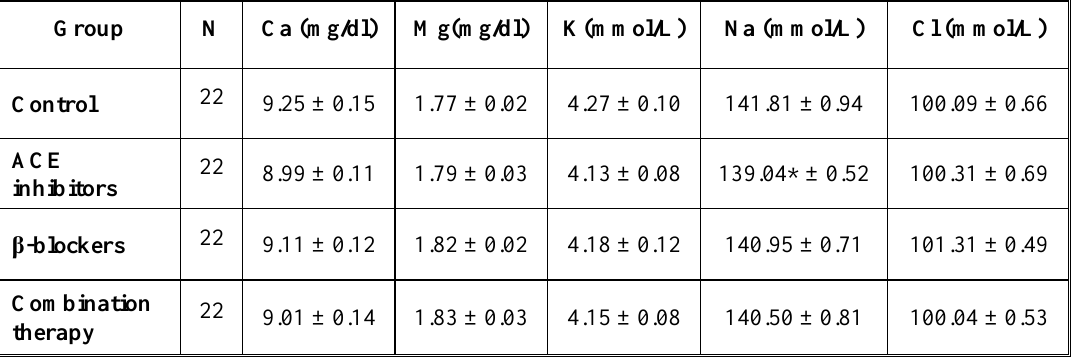
Table 8: Serum electrolytes (Ca +2 , Mg +2 , K +, Na + , Cl - ) in control healthy individuals and hypertensive patients treated with different antihypertensive drug regimens. Each value represents mean± standard error of mean.